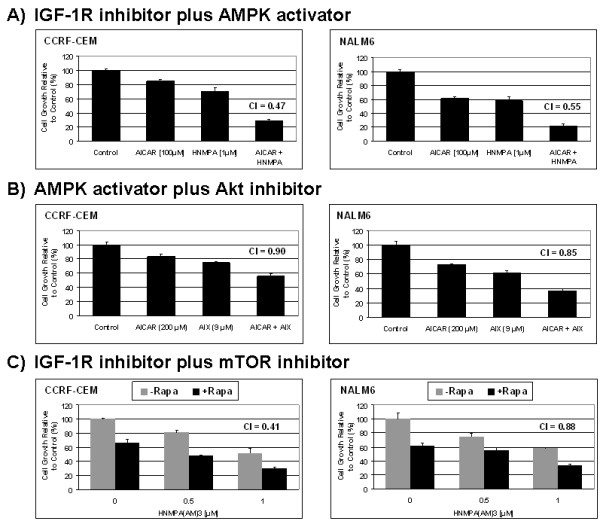
Simultaneous inhibition of IGF-1R with drug altering AMPK, mTOR, or Akt signaling pathway induces synergistic growth inhibition in ALL cell lines. Cell growth of ALL CCRF-CEM and NALM6 cells treated with either AICAR (100 μM) plus the IGF-1R inhibitor HNMPA(AM)3 (1.0 μM) (panel A); AICAR (200 μM) plus the Akt inhibitor-X (AIX, 9.0 μM) (panel B); or rapamycin (1.0 μg/ml) plus HNMPA(AM)3 (0.5 and 1.0 μM) (panel C). Cells were treated with either agent alone or in combination at the indicated doses and incubated for 24 h at 37°C. The cell growth values are expressed as a percentage relative to those obtained with control cells (mean ± SEM, n = 3). Combination index (CI) values were determined for each drug combination as described in Methods (CI <1 indicates synergism).